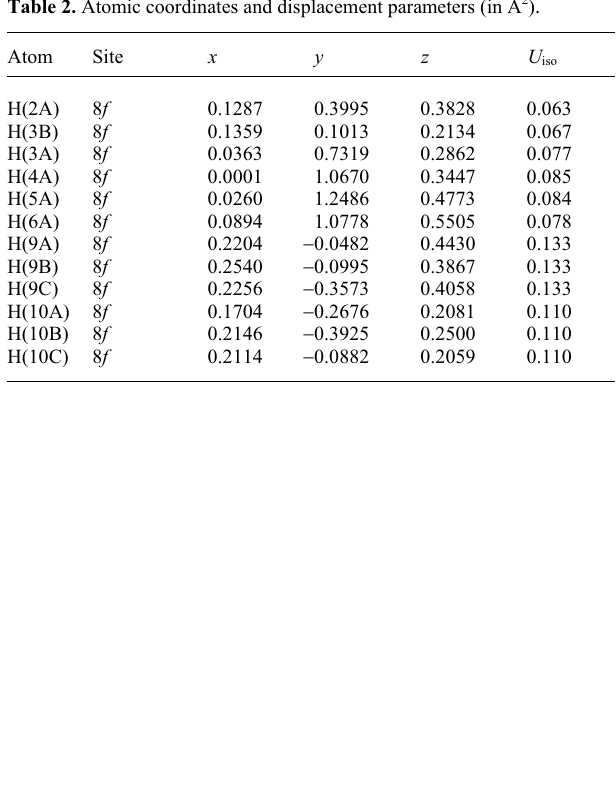
Table 2. Atomic coordinates and displacement parameters (in Å 2 )